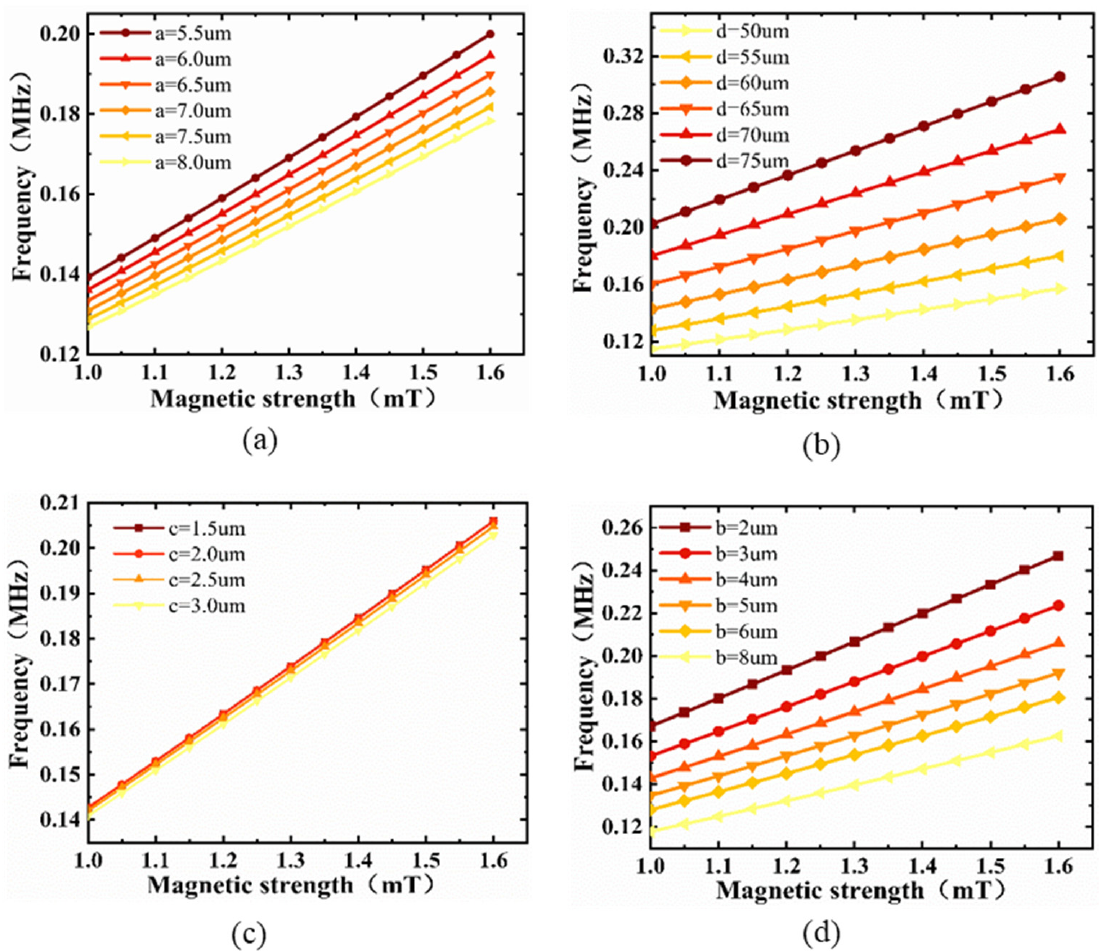
Figure 5. Resonance frequency versus external magnetic field in the range of 1–1.6 mT for various sizes of ( a ) Fe–Ga alloy, ( b ) groove, ( c ) SiO 2 , and ( d ) Si. In order to study the influence of the size of the graphene on the magnetic sensor, the influence of the length, width, and thickness of the membrane on its resonance frequency were simulated, as shown in Figure 6a,b. When W = 2 µ m, the resonance frequency increased gradually with decreasing length, and the rate of increase gradually became larger. This is consistent with the description of Equation (5). When L = 2 µ m, W = 2 µ m, the resonance frequency was greater than 2.5 MHz under an external magnetic field of 1.6 mT. When L = 2 µ m, the resonance frequency hardly changed with the increase in width. It can be seen that the L of the membrane had a greater impact on its resonance frequency, and the changes in W hardly affected the resonance frequency. In order to obtain sensitivity as a function of length and width, a series of points with L and W ( L ≥ W ) between 2 µ m and 10 µ m were simulated. Figure 6c shows its three-dimensional